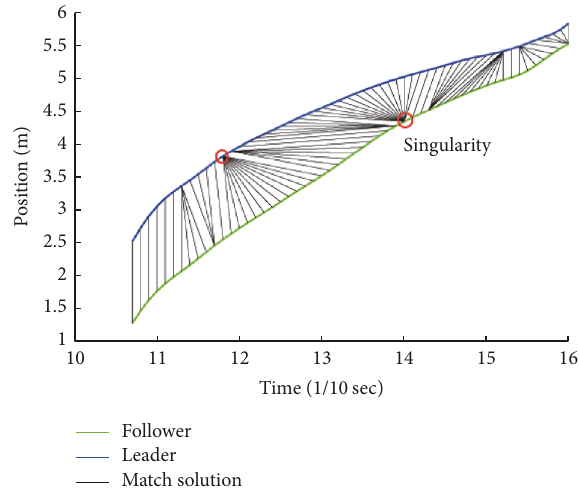
Figure 6: Example output for DTW pedestrian data match with highlighted singularity.